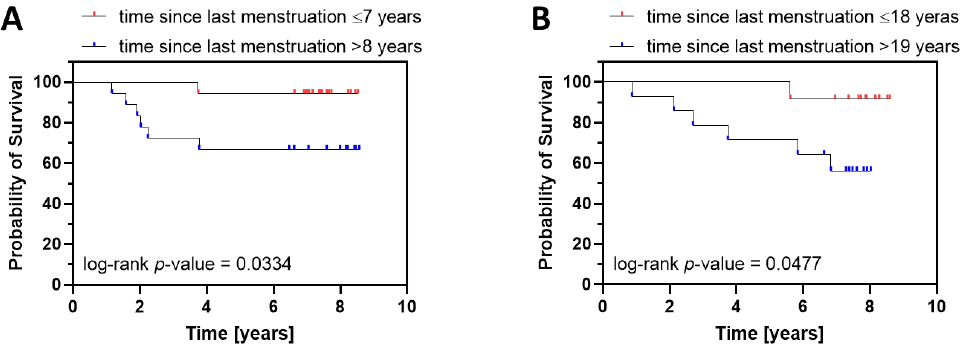
Figure 3. Kaplan – Meier survival analysis for younger (( A ), 45 – 64 years old) and older (( B ), 65 and more) endometrial cancer patients characterized by shorter and longer time since last menstruation. ( A ). The survival curve for patients with shorter time since last menstruation (≤7) was significantly different from the curve for patients with longer time since last menstruation (>8). Statistics: p -value (log-rank test) = 0.0334; HR (log-rank) 0.1404, 95% C.I. 0.03174 – 0.6213. (B) The same relationship was observed in older patients. Statistics: p -value (log-rank test) = 0.0477; HR (log-rank) = 0.1564, 95%